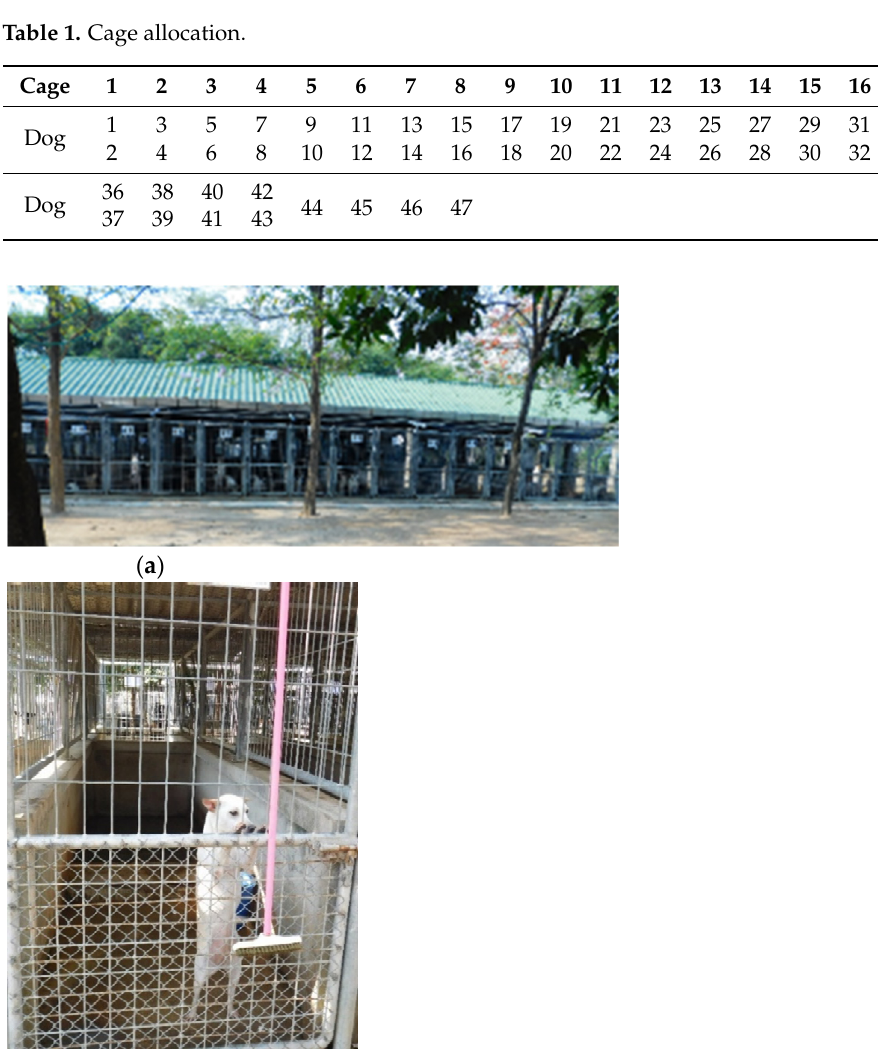
Figure 1. ( a , b ) Standard cages at the dog shelter in Taptan, Uthai-Thani province, Thailand. Animals were fed once per day with commercial dog food (Blue’s canine special, BLUEFALO Co. Ltd., Nakhon Pathom, Thailand). For the duration of the study, feeding time was moved from around noon to the later hours of the day, after trials had finished. Water was offered at libitum. Cages were completely cleaned once per day.